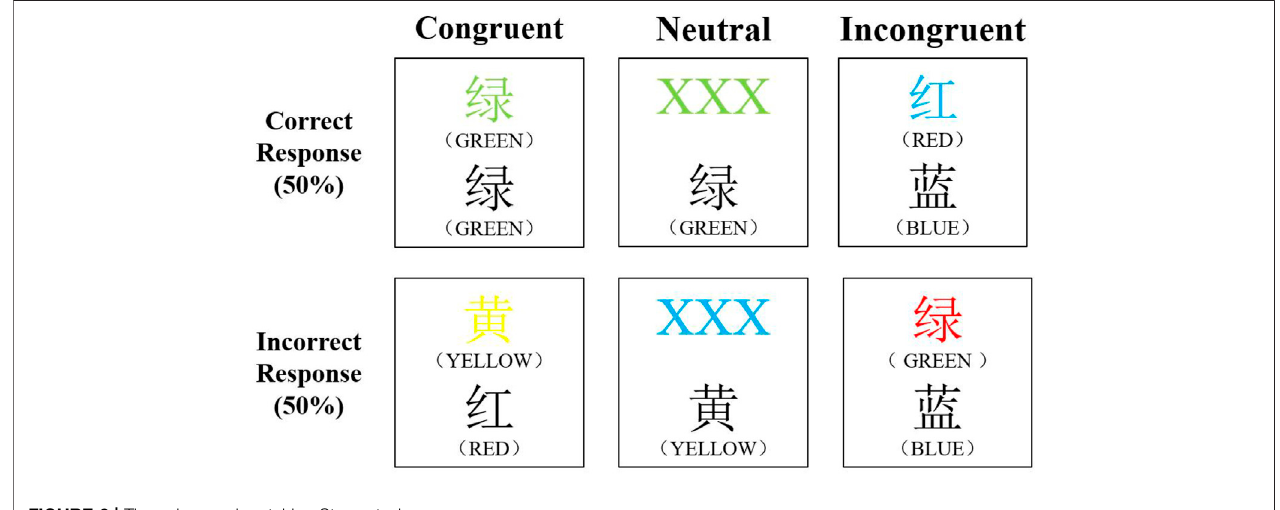
FIGURE 2 | The color-word matching Stroop task.